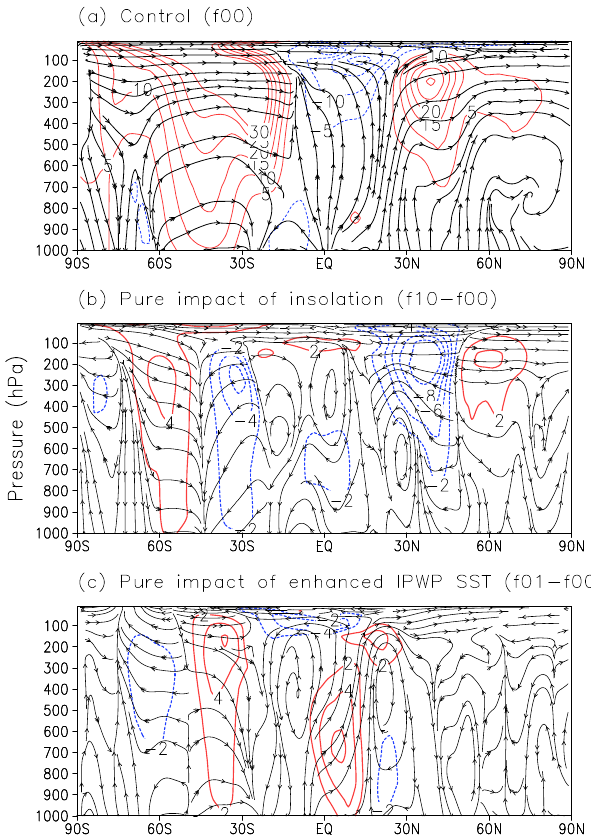
Figure 6. Seasonal cycle of precipitation anomaly over northern (a) and southern (b) China. Contributions of insolation, of enhanced IPWP SST, their synergism and combined effect are